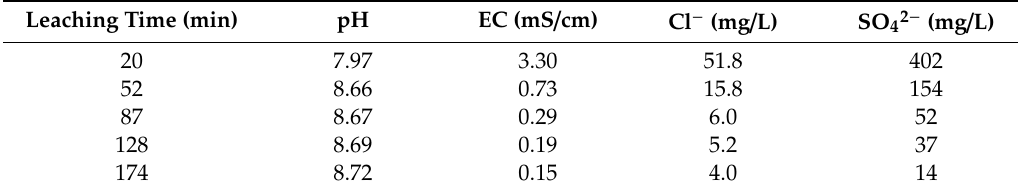
Table 2. Variation of pH, EC and ions with time in the leachates of soil /